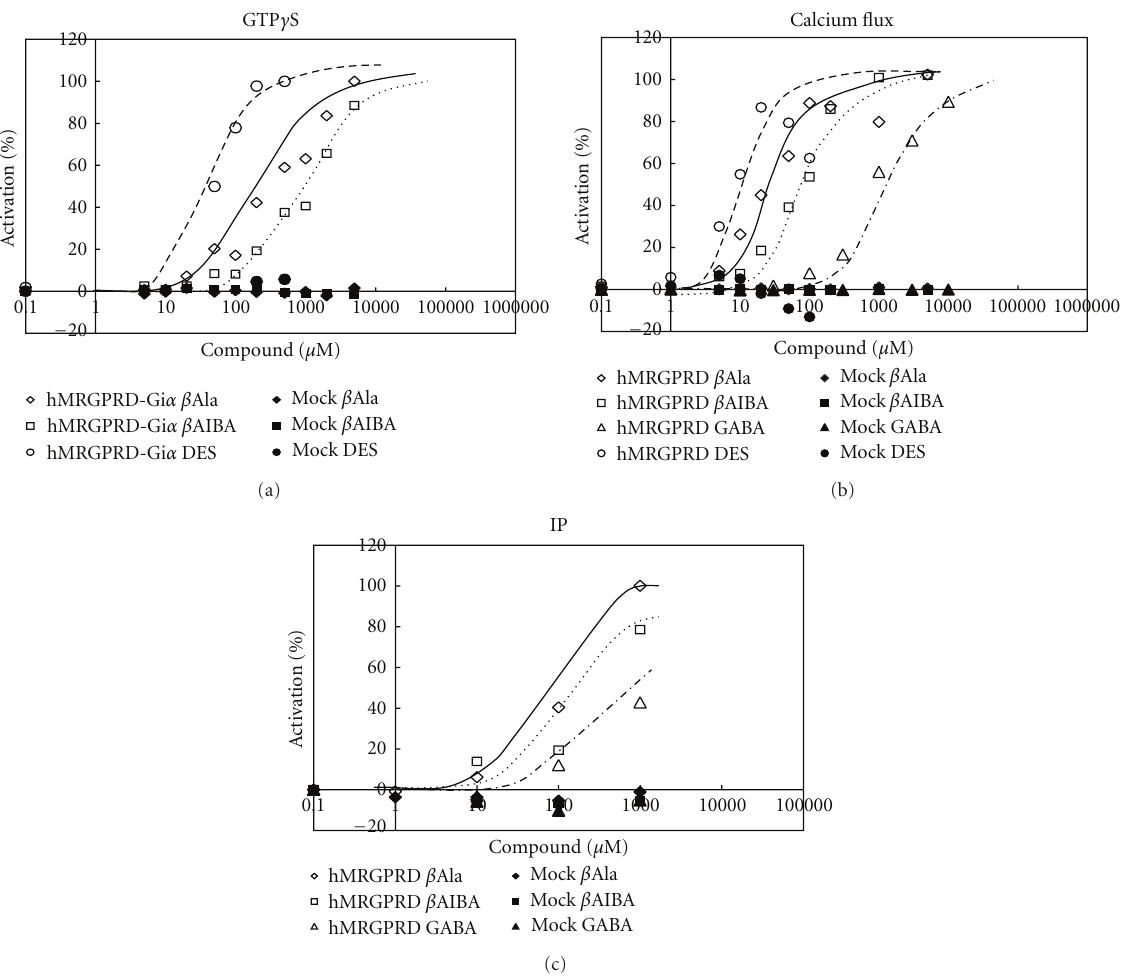
Figure 3: Agonistic e ff ects of physiologically active substances on MRGPRD. Representative dose-dependent curves of physiologically active substances in (a) GTP γ S binding assay, (b) calcium flux assay, and (c) IP assay are shown. Each value expresses the percentage of control with maximum e ffi cacy in each assay. β Ala on MRGPRD (open diamond), β AIBA on MRGPRD (open square), GABA on MRGPRD (open triangle). DES on MRGPRD (open circle), β Ala on mock (closed diamond), β AIBA on mock (closed square), GABA on mock (closed triangle), DES on mock (closed